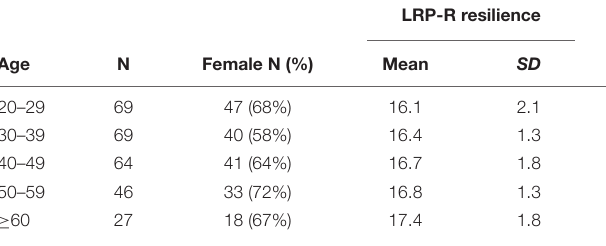
TABLE 1 | Sample characteristics by age